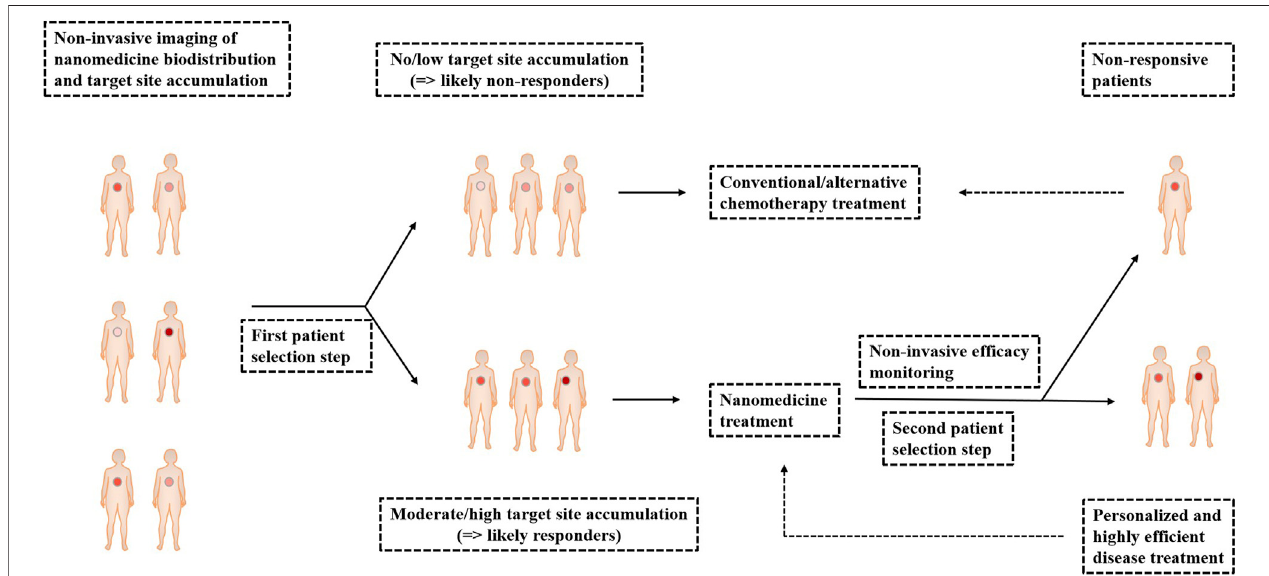
FIGURE 11 | Personalized cancer nanomedicine. The nanomedicine biodistribution and target site accumulation of nanomedicine formulations labeled with contrast agents can preselect patients on the basis of noninvasive imaging ( fi rst patient selection step). And, then, the responders of moderate/high target site accumulation can either be assigned to nanomedicine treatment (second patient selection step). For the above two steps, the nonresponders of no/low target site accumulation and the nonresponsive patients of reasonable target site accumulation can be allocated to treatment with conventional/alternative chemotherapy to assureindividualizedandimprovedinterventions:personalizedandhighlyef fi cientdiseasetreatment.Finally,nanomedicinetreatmentisrepeatedlyusedforpersonalized and highly ef fi cient disease treatment.